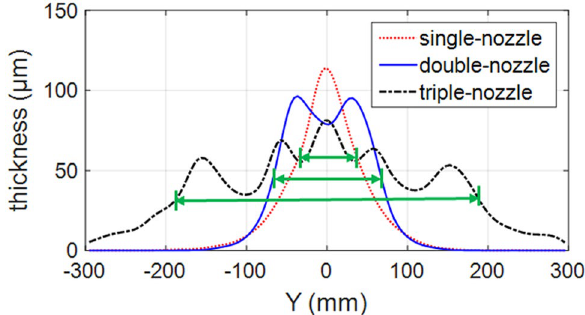
Fig. 12 Comparison of coating thickness distribution profiles of three-nozzle, double-nozzle and single-nozzle along Y-axis [21,